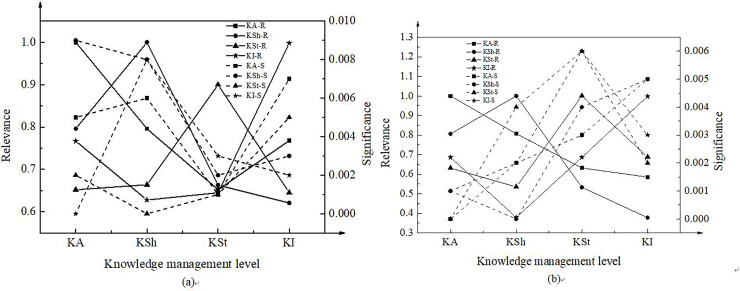
Correlation analysis of enterprise knowledge management level: (a) construction-related enterprises; (b) engineering cost consulting enterprises (In the figure, KA, KSh, KSt, KI represent knowledge acquisition, knowledge sharing, knowledge storage, and knowledge innovation).